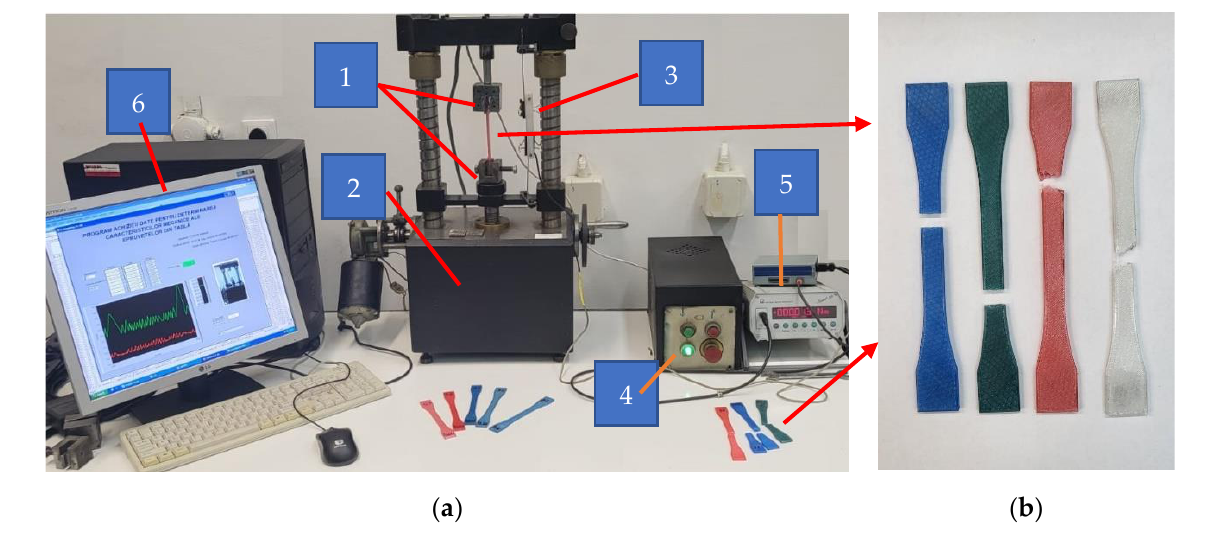
Figure 9. Tensile testing stand: ( a ) components; ( b ) tested specimens. Impact energy tests were performed using an industrial Galbadini Impact 300 pendulum hammer (Figure 10).